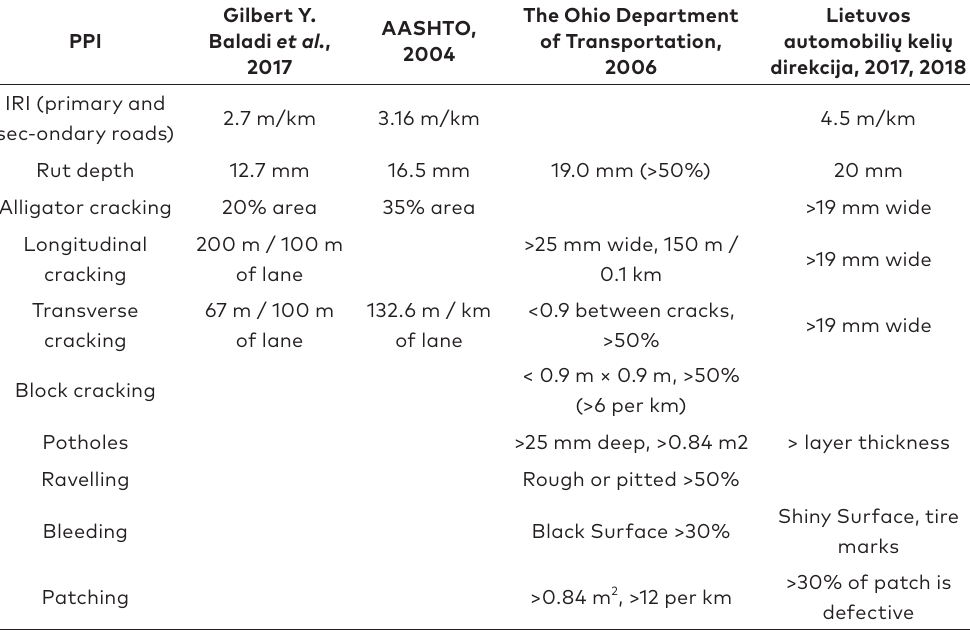
Table 1. Comparison of PPI threshold